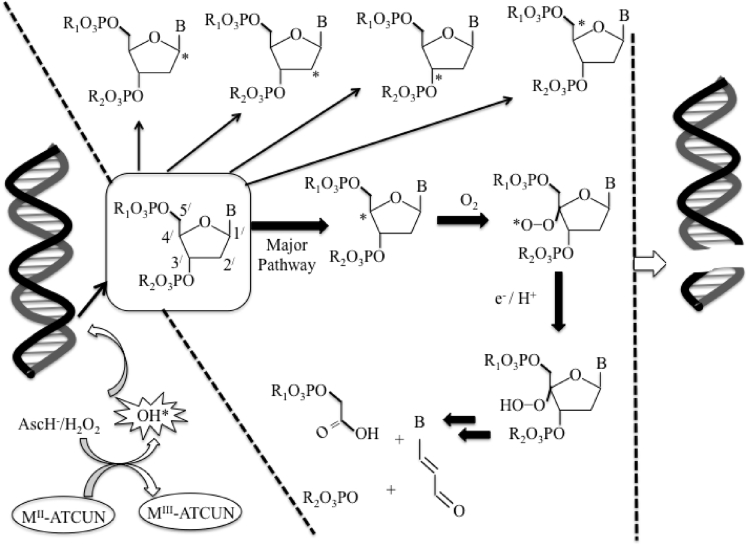
Schematic Representation of M-ATCUN Induces Oxidatively DNA Strand Scission by Sugar-Hydrogen Abstraction to Yield C1/-, or C2/-, or C3/-, or C4/-, or C5/-, Deoxyribosyl Radical.(modified from Pogozelski and Tullius, 1998). B = Nucleobase.